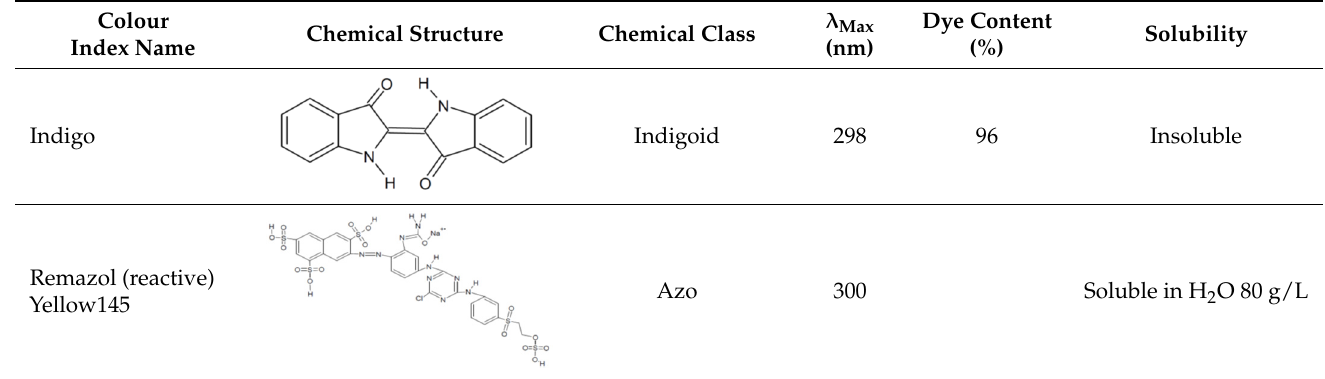
Table 1. Characteristics of the dyes used in the present study.